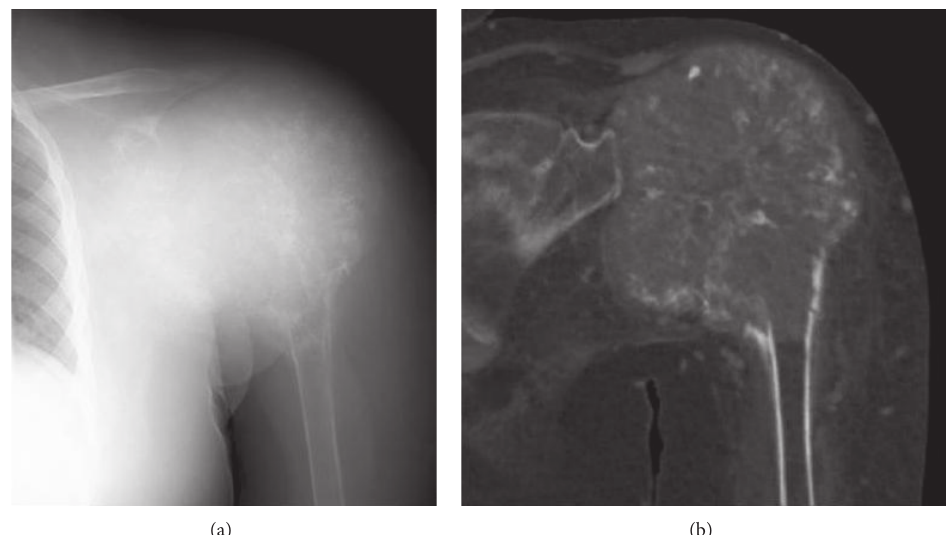
Figure 1: Radiograph (a) and CT reconstruction (b) showed an expanded, destructive lesion of the proximal humerus containing irregular calcifications. There was almost no cortical margin around the lesion.